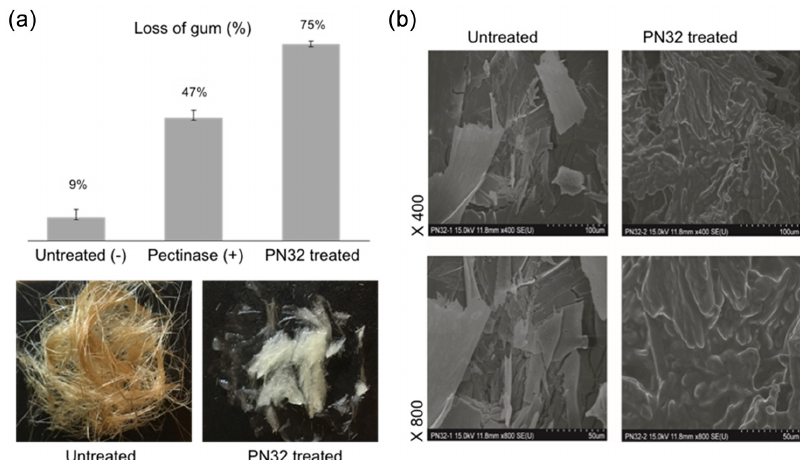
Figure 5. ( a ) Gum loss of the ramie fibers after 2 h treatment by polygalacturonase. The untreated (negative control) means that only a buffer was used, and the positive control means that treatment was done by commercial pectinase (from Aspergillus niger , Sigma-Aldrich, St. Louis, MO, USA). Ramie fibers were untreated and PN32-treated (100 U/mg). ( b ) Scanning electron micrographs of ramie fiber degradation by PN32. From left: Control and PN32-treated (100 U/mg). From top: Images at various magnifications (400× and 800×).